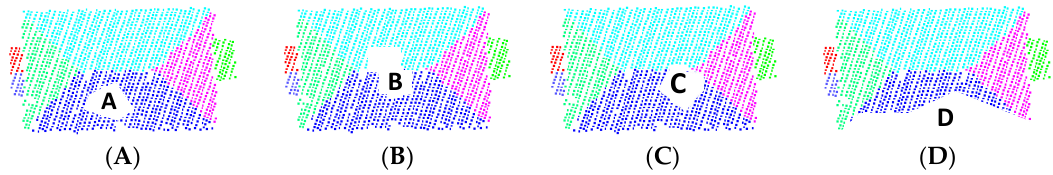
Figure 14. Impacts of missing data on feature recognition. ( A ) The missing part located in the interior of planar segment has no impacts; ( B ) The missing parts of the interior and boundary do not impact feature recognition; ( C ) The missing parts of the interior and boundary impacts the identification of topological relations; ( D ) A large area of missing part has impacts on the determination of geometric shapes and topological relations.